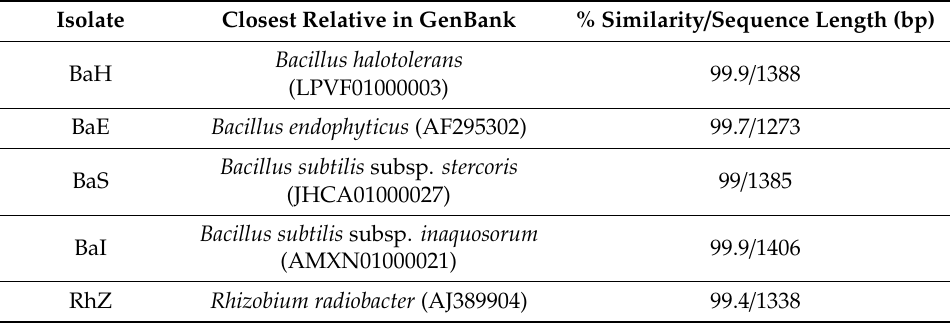
Table 1. Results of 16SrDNA sequencing.